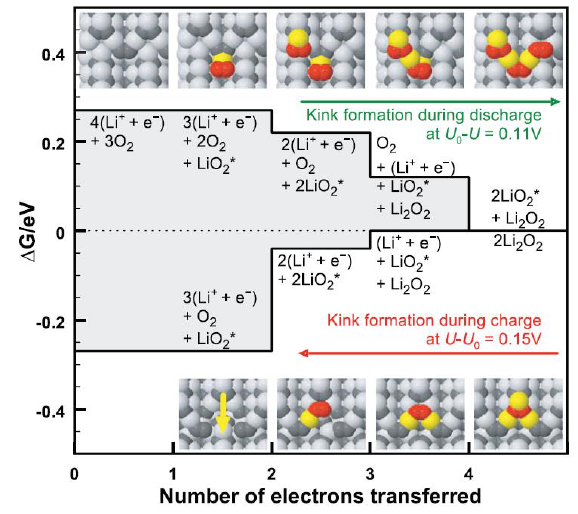
Figure 43. The most facile mode for crystal growth/dissolution on perfect steps of Li 2 O 2 (1–100) modeled by the initial formation of kinks. The images show the intermediate states of the cathode surface, where colors highlight atoms that have adsorbed during discharge or atoms that have yet to desorb during charge. Colors: O is dark gray and red; Li is light gray and yellow. Energies are plotted for the total system, where Li and O 2 that are not adsorbed are included in solution (Li + + e − ) and O 2 as the labels show. During discharge, the potential-limiting step is the adsorption of the second LiO 2 in the valley site, which amounts to an over-potential of 0.11 V for discharge on a step. During charge the removal of the first Li is potential-limiting resulting in an overpotential of 0.15 V for charge. Reprinted from Hummelshoj et al. [88] with the permission of AIP Publishing.